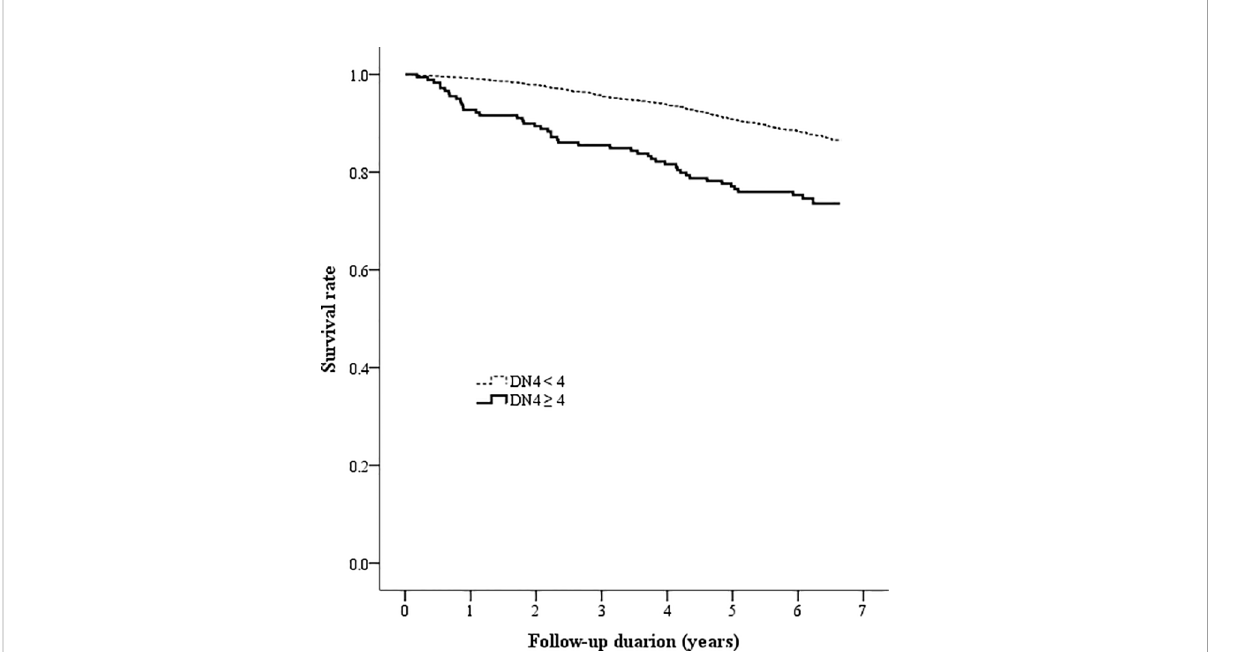
FIGURE 3 Kaplan-Meier curves showing the survival rate between the two patient groups categorized by the baseline DN4 score (DN4 = Douleur Neuropathique en 4